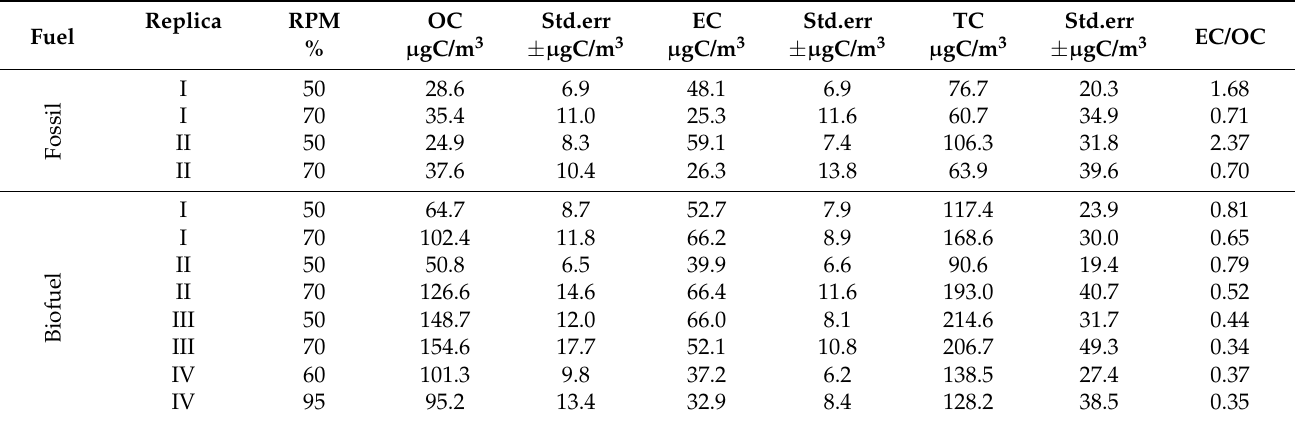
Table 4. Emission concentrations for OC, EC, and TC measured during the different tests—already accounting for the dilution factors and background effect—and the EC/OC